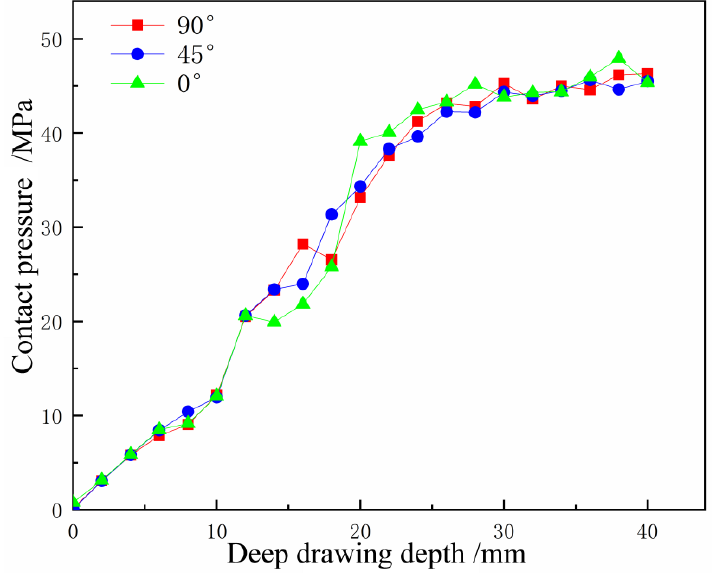
Figure 23. Reverse bending strain and surface roughness change curves at different drawbead heights.